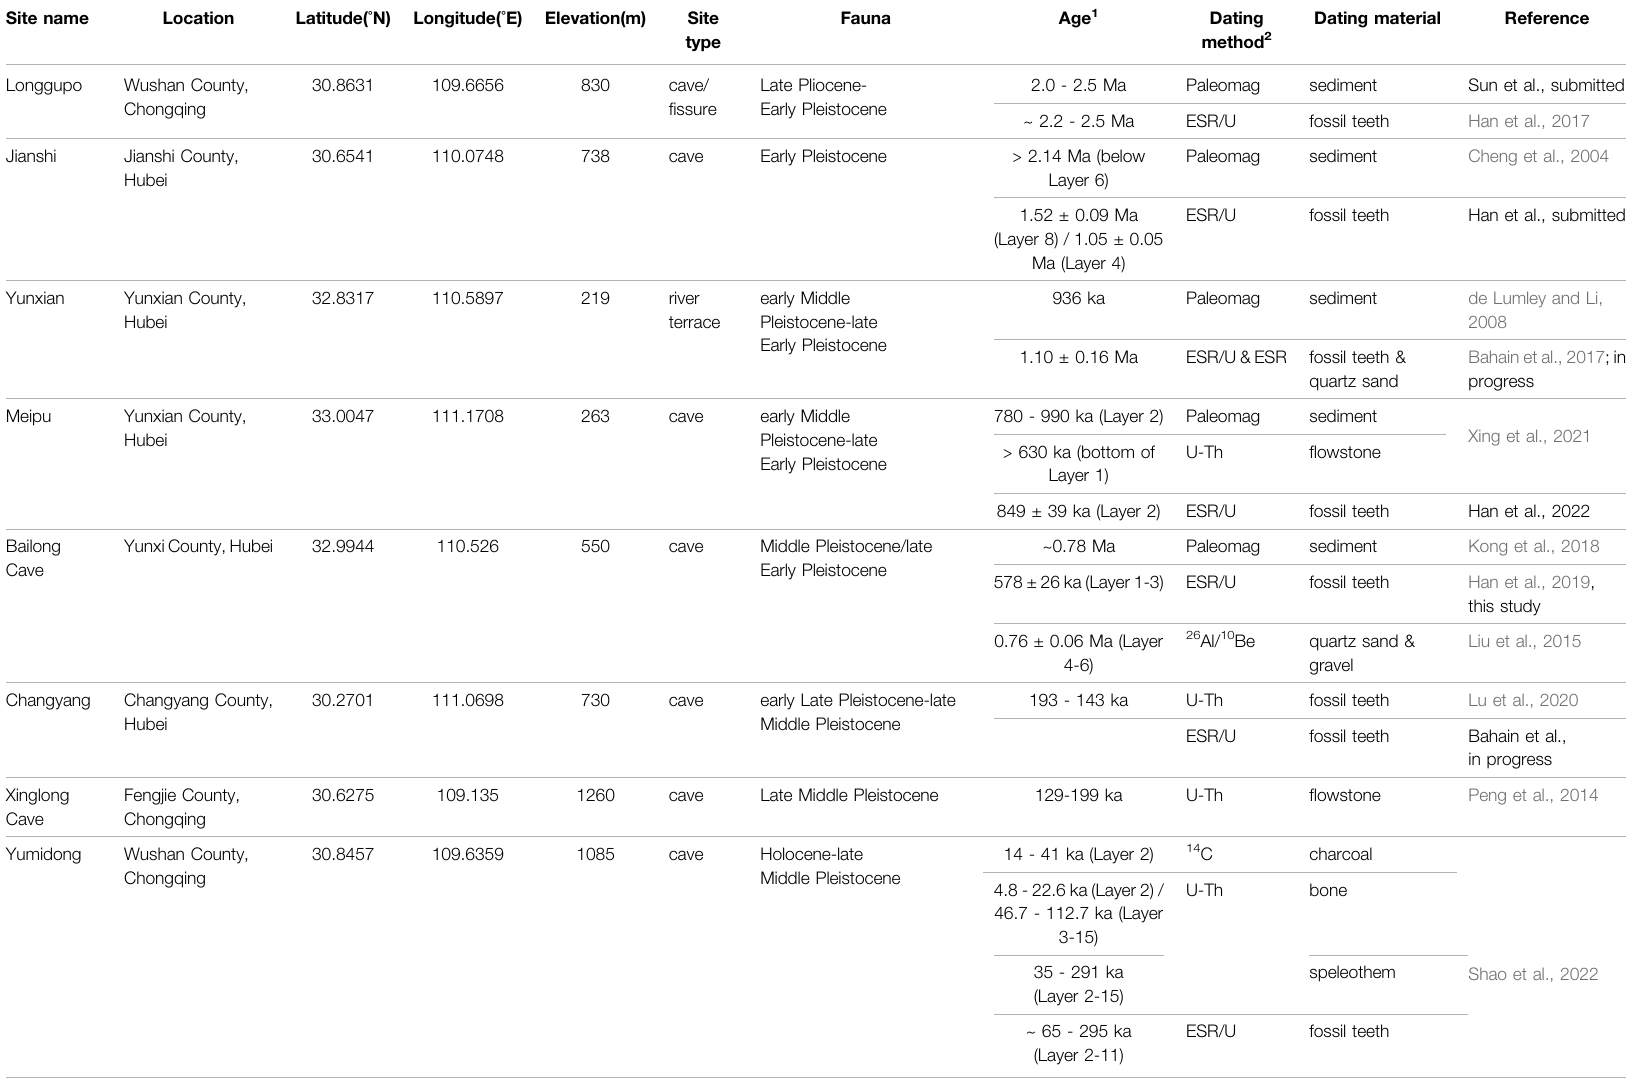
1 Note: The stratigraphic layer of the dated sample was present in parentheses. No layer information was given if the age range brackets the hominin fossil layer or estimated by paleomagnetism. 2 Paleomag - Paleomagnetism; ESR/U - Coupled ESR/U-series method; 26 Al/ 10 Be - Cosmogenic burial dating